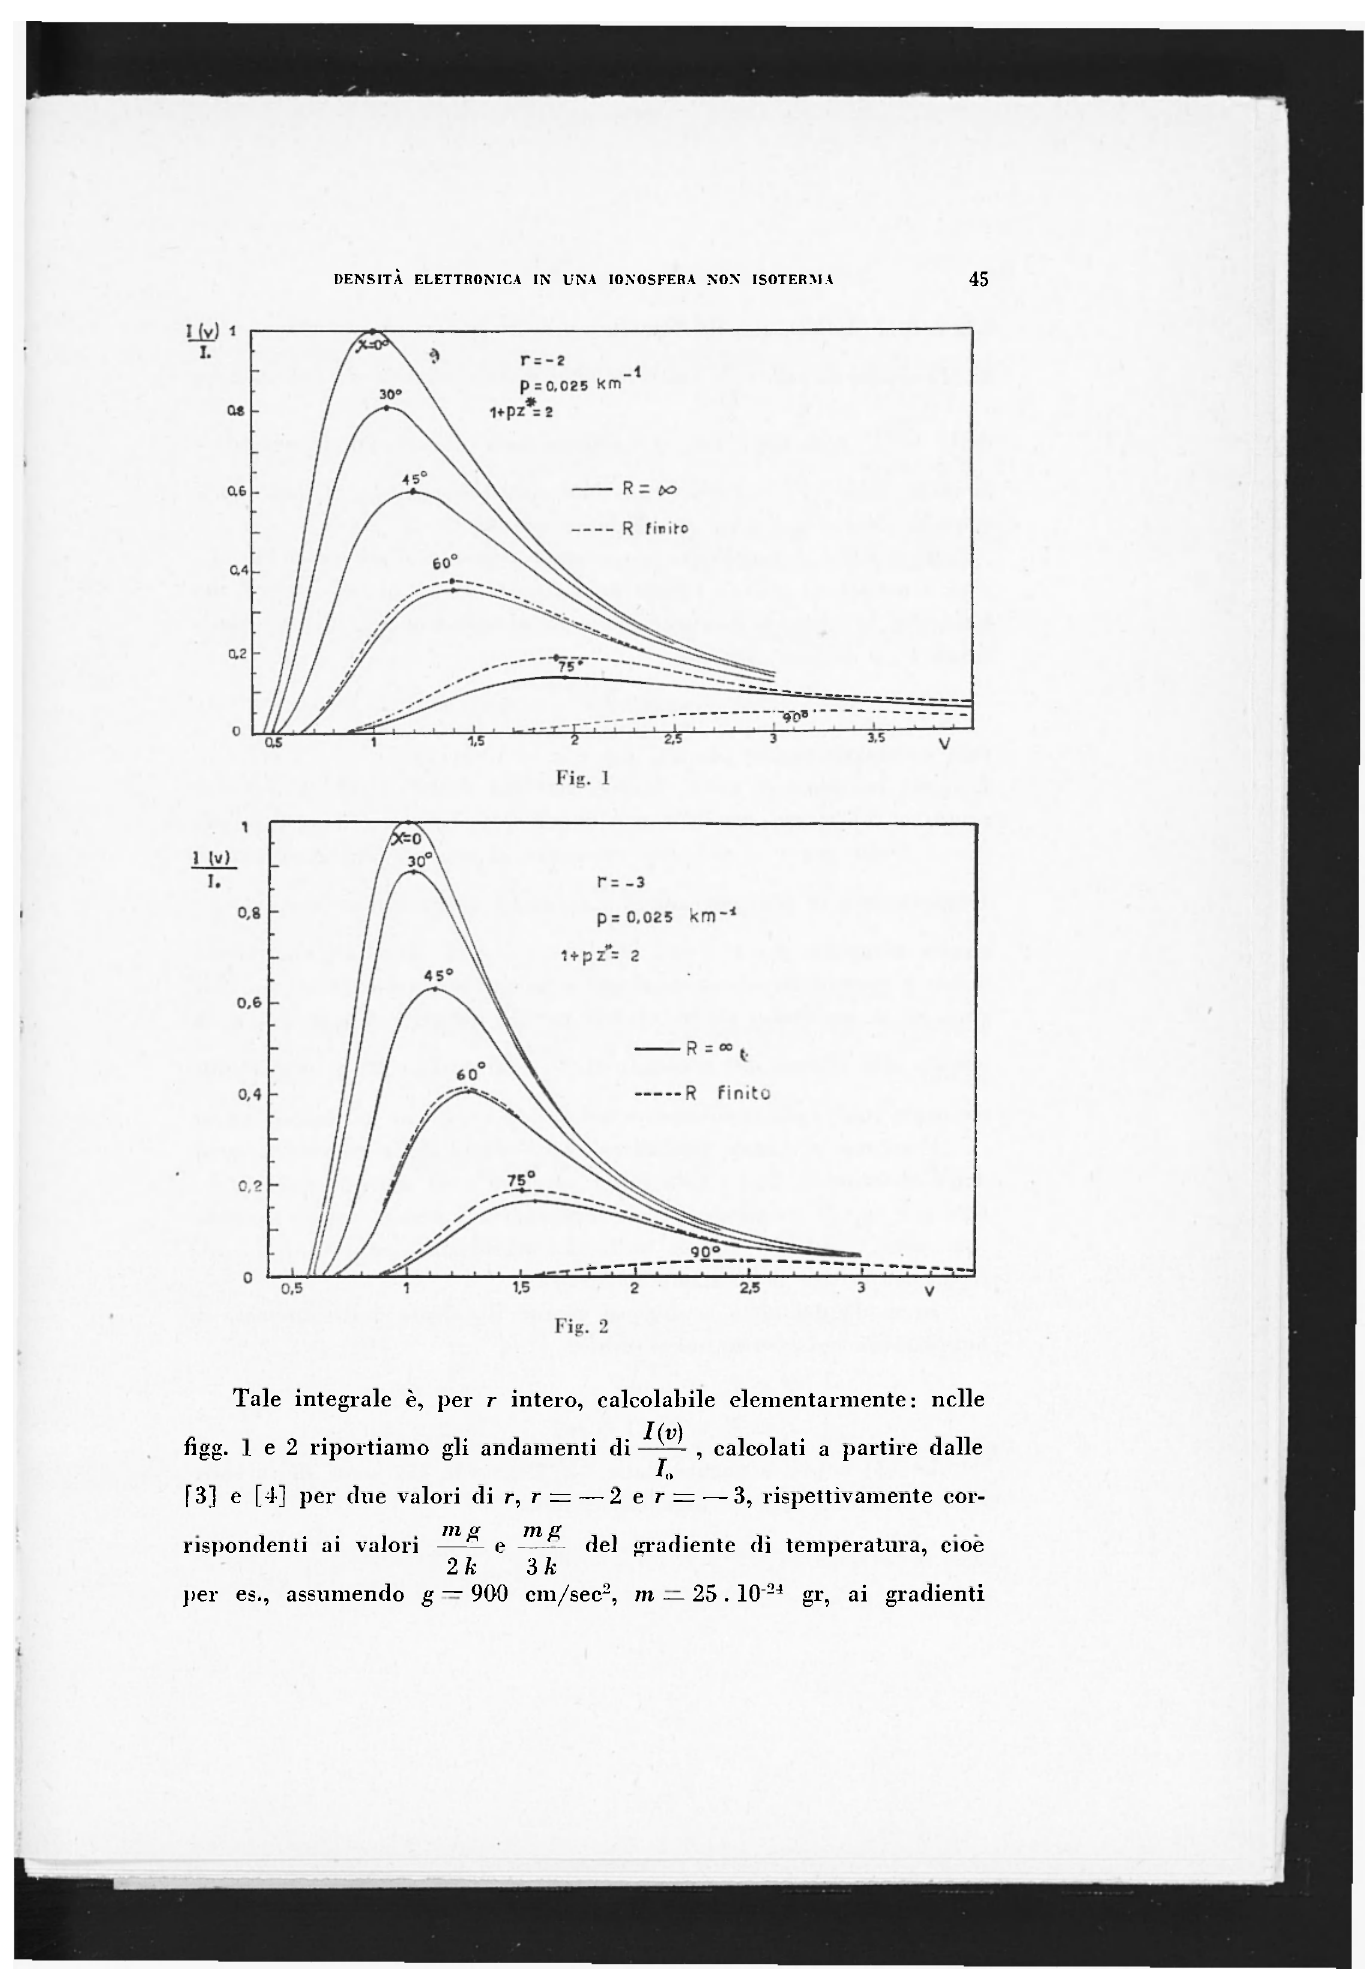
Tale integrale è, per r intero, calcolabile elementarmente : nelle figg. 1 e 2 riportiamo gli andamenti di IS^Ì. ? calcolati a partire dalle In [3] e [4] per due valori di r, r = —2 e r = — 3, rispettivamente cor- i . • 1,1 fi m H ^ i T i- rispondenti ai valori —— e —— del gradiente di temperatura, cioè 2 k 3 k per es., assumendo g — 900 cm/sec 2 , m — 25 . IO" 24 gr, ai